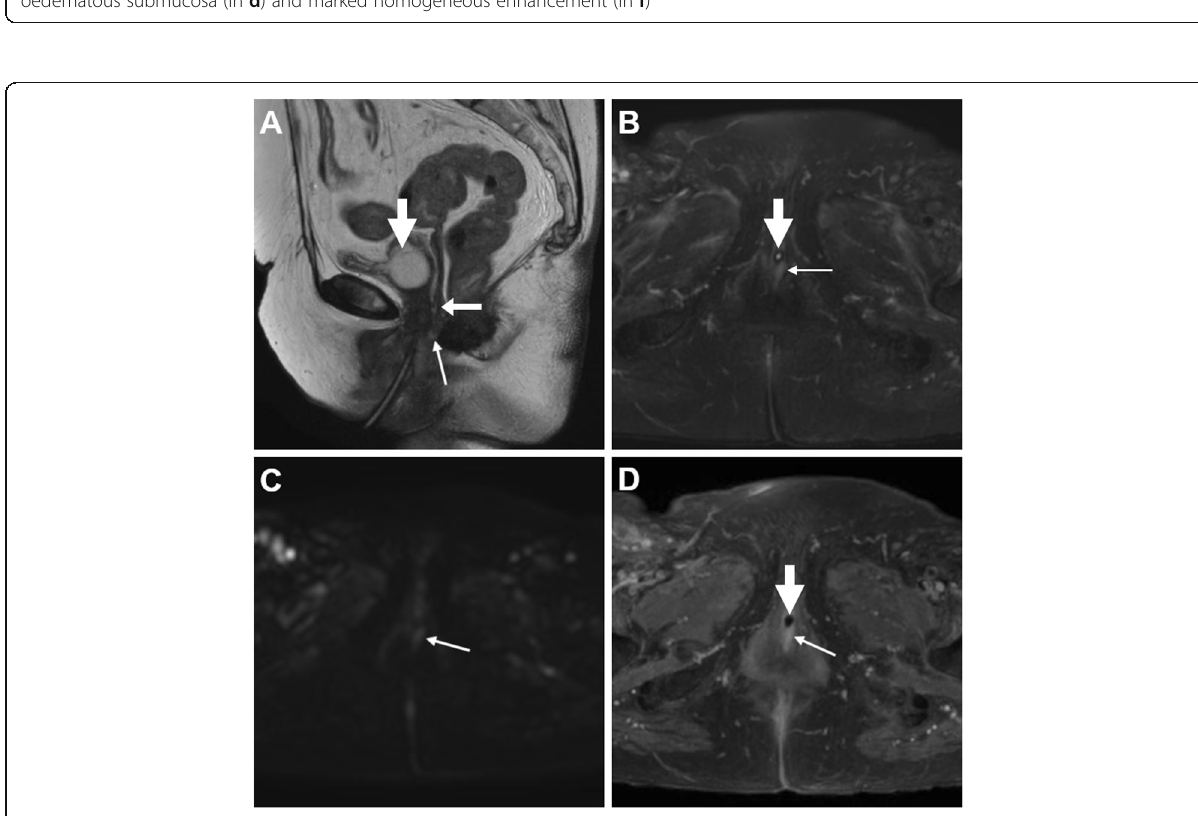
Fig. 14 Urethro-VF in an elderly woman seen at MRI as subtle midline track (thin arrows) between the distal third of the vagina (arrow) and urethra containing Foley catheter (thick arrows), with high signal intensity on T2- ( a ), FS T2-weighted ( b ) and high b value DW ( c ) sequences, positive enhancement on post-gadolinium FS T1-weighted acquisition ( d